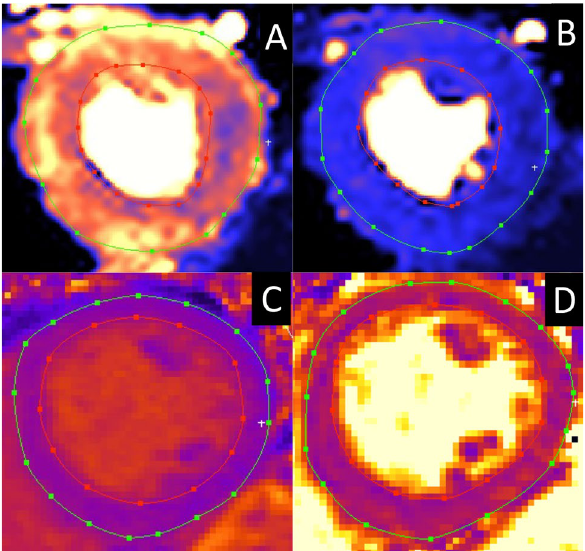
Figure 2. Examples of segmentations of endo- and epicardial borders. The image shows segmentations of the respetives maps: ( A ) stresss perfusion map, ( B ) rest perfusion map, ( C ) rest native T1 map and ( D ) rest native T2